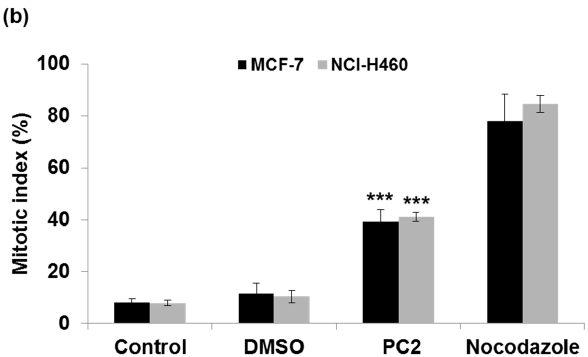
Figure 2. Treatment with PC2 arrests MCF-7 and NCI-H460 cells in mitosis. ( a ) Mitotic cells (rounded) accumulated in cell cultures after 24 h with the compound (PC2), as shown by phase contrast microscopy and confirmed by DAPI staining of DNA. Nocodazole was used as a positive control. Scale bar = 10 μ m; ( b ) Mitotic index graph showing accumulation of mitotic cells by 24 h of treatment. (***) represents p < 0.001, treated versus DMSO.